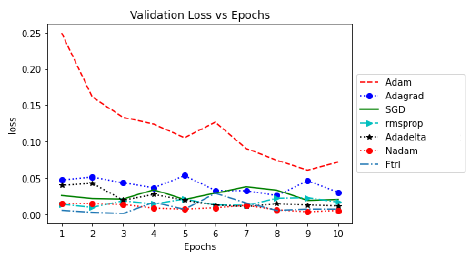
Fig. 6. Validation loss by